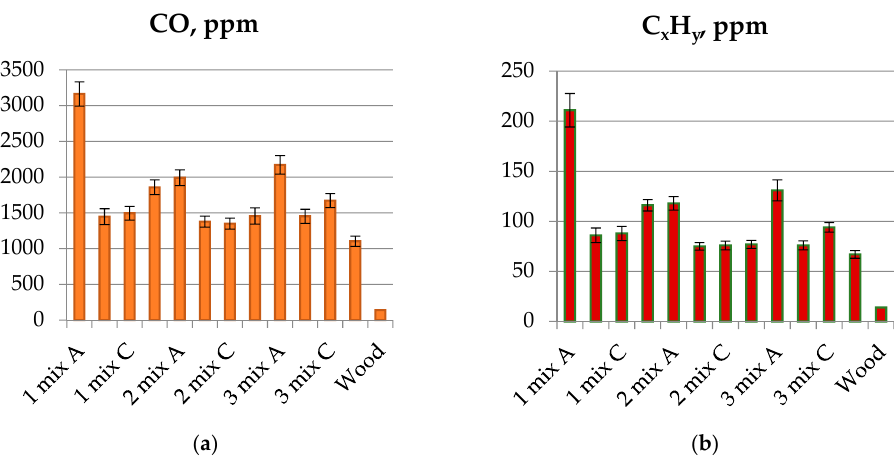
Figure 7. CO ( a ) and CxHy ( b ) emissions from burning of granulated faba bean waste and potato peels.